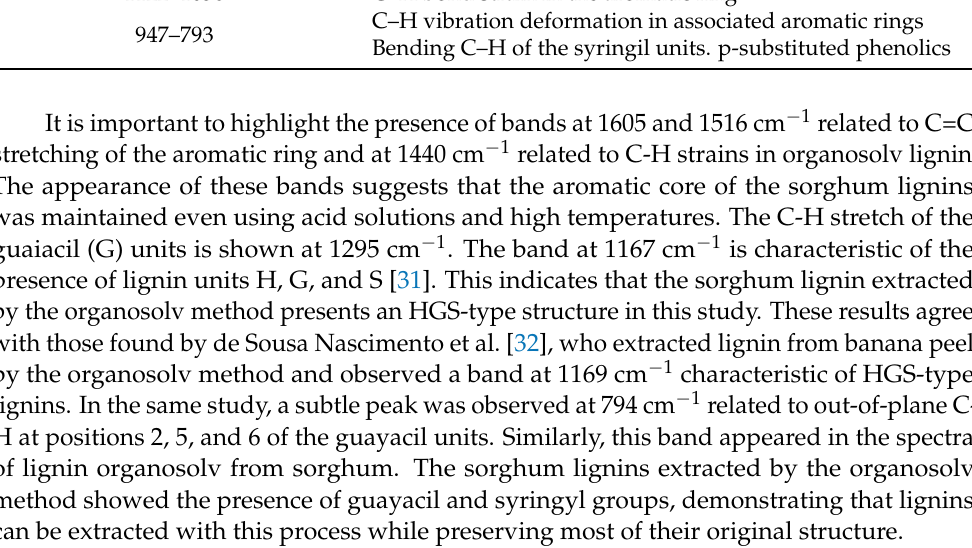
Wave Number (cm − 1